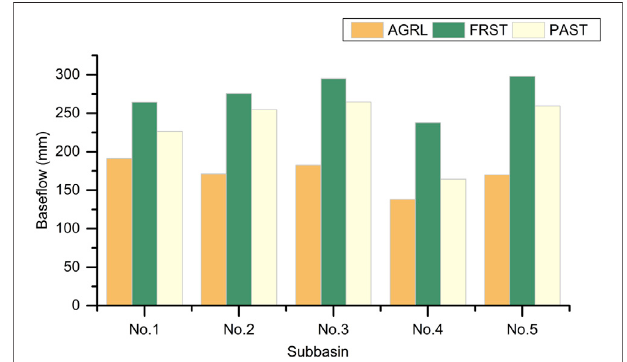
FIGURE 10 | Average annual base fl ow depth in each subbasin under different land use